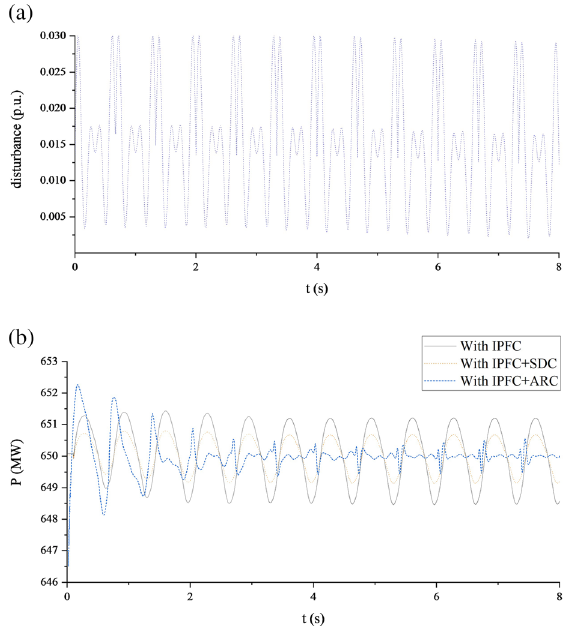
Fig. 11 Forced oscillation in the main control transmission line with complex disturbance: a Disturbance signal; b Simulation results of P ik from two cases: with IPFC and IPFC based on ARC